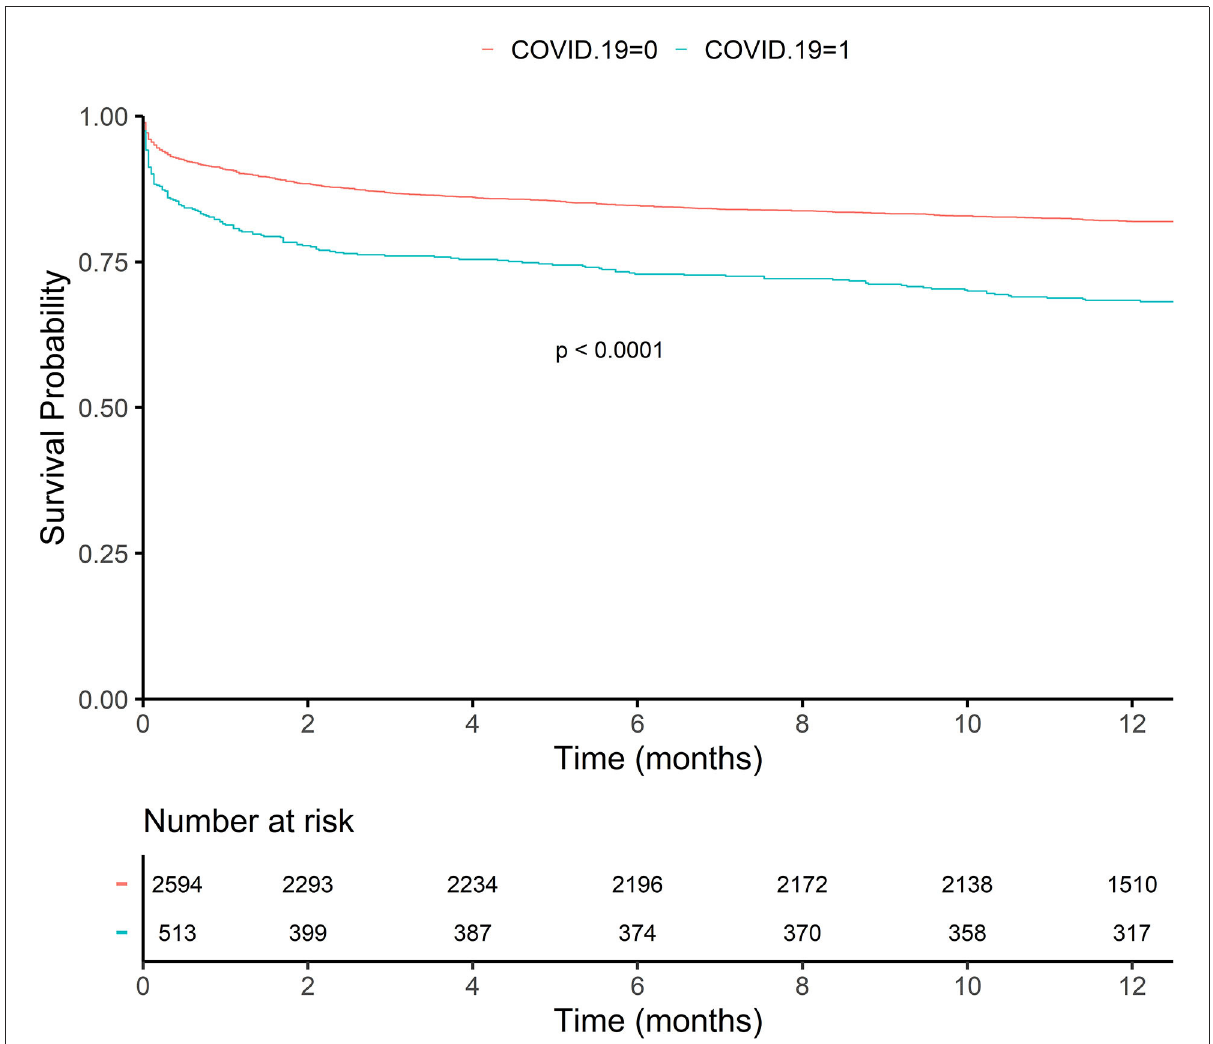
FIGURE2 The Kaplan–Meier curve showing the survival probability for patients with and without COVID-19. The red line represents patients without COVID-19. The blue line represents patients with COVID-19.